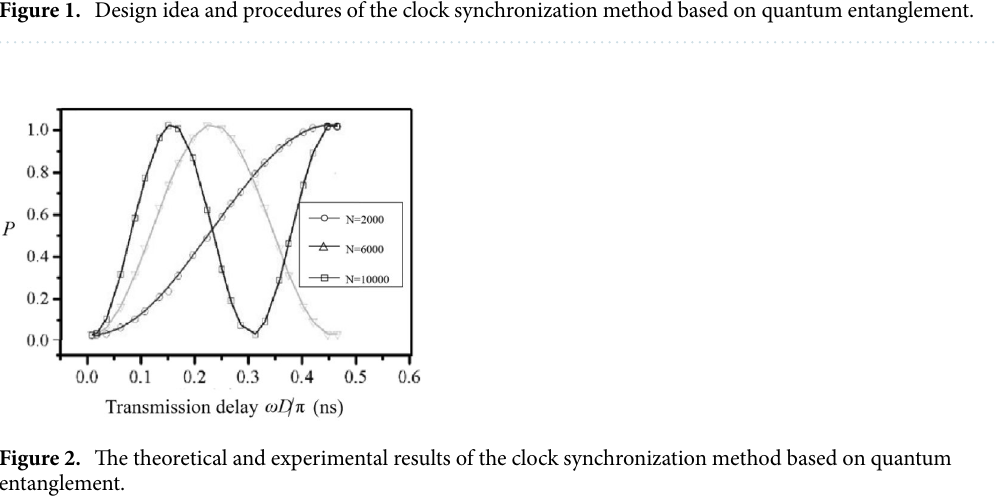
Figure 1. Design idea and procedures of the clock synchronization method based on quantum entanglement.